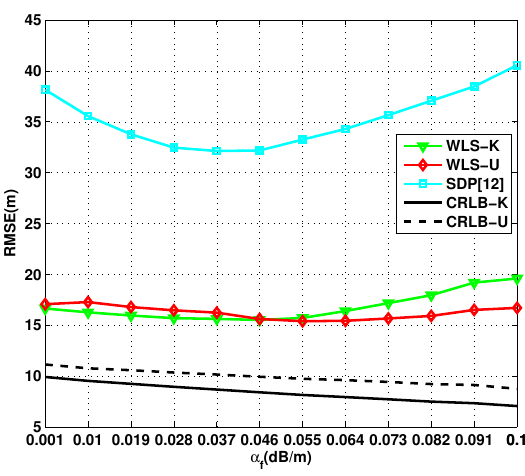
Figure 7. RMSE versus absorption coefficient α f when σ = 4 dB, N = 10, and ρ = 0.8.